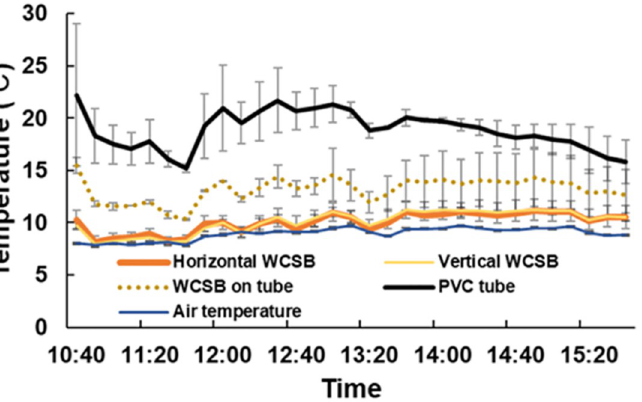
Fig 5. Temperature measurements on the roof of West 5 Building of Kyushu University on 19 January 2022. Lines represent mean values and error bars represent standard